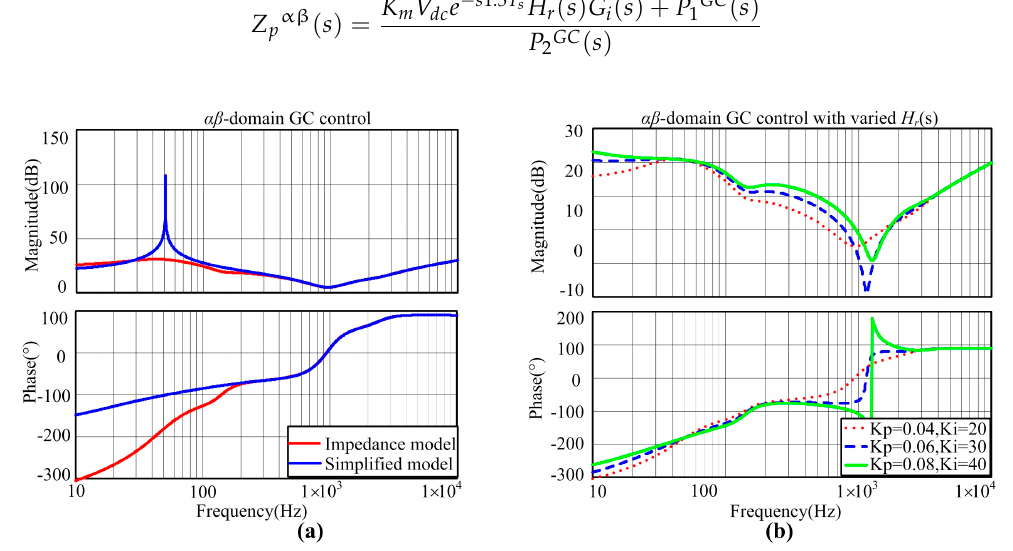
Figure 12. Impedance comparison in medium-frequency range. ( a ) Impedance comparison in medium-frequency range; ( b ) Impedance response with different current controller parameters.